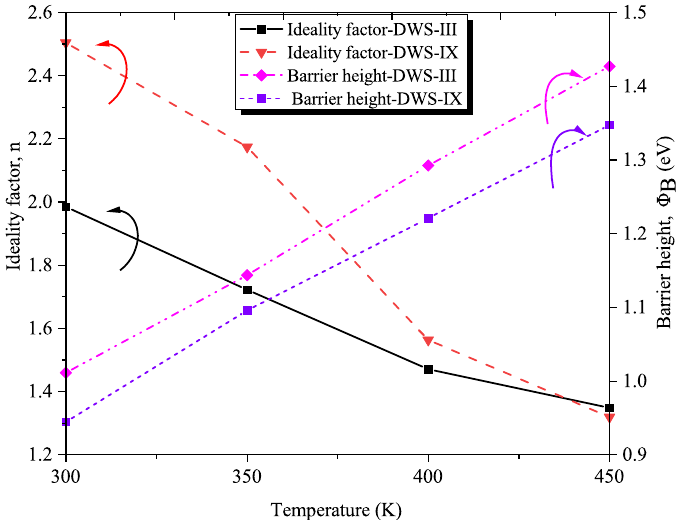
Figure 4. Ideality factor and barrier height investigation of diffusion welded p -type 4H-SiC-SBD (DWS# III and DWS# IX) as a function of various temperatures deduced from I-V